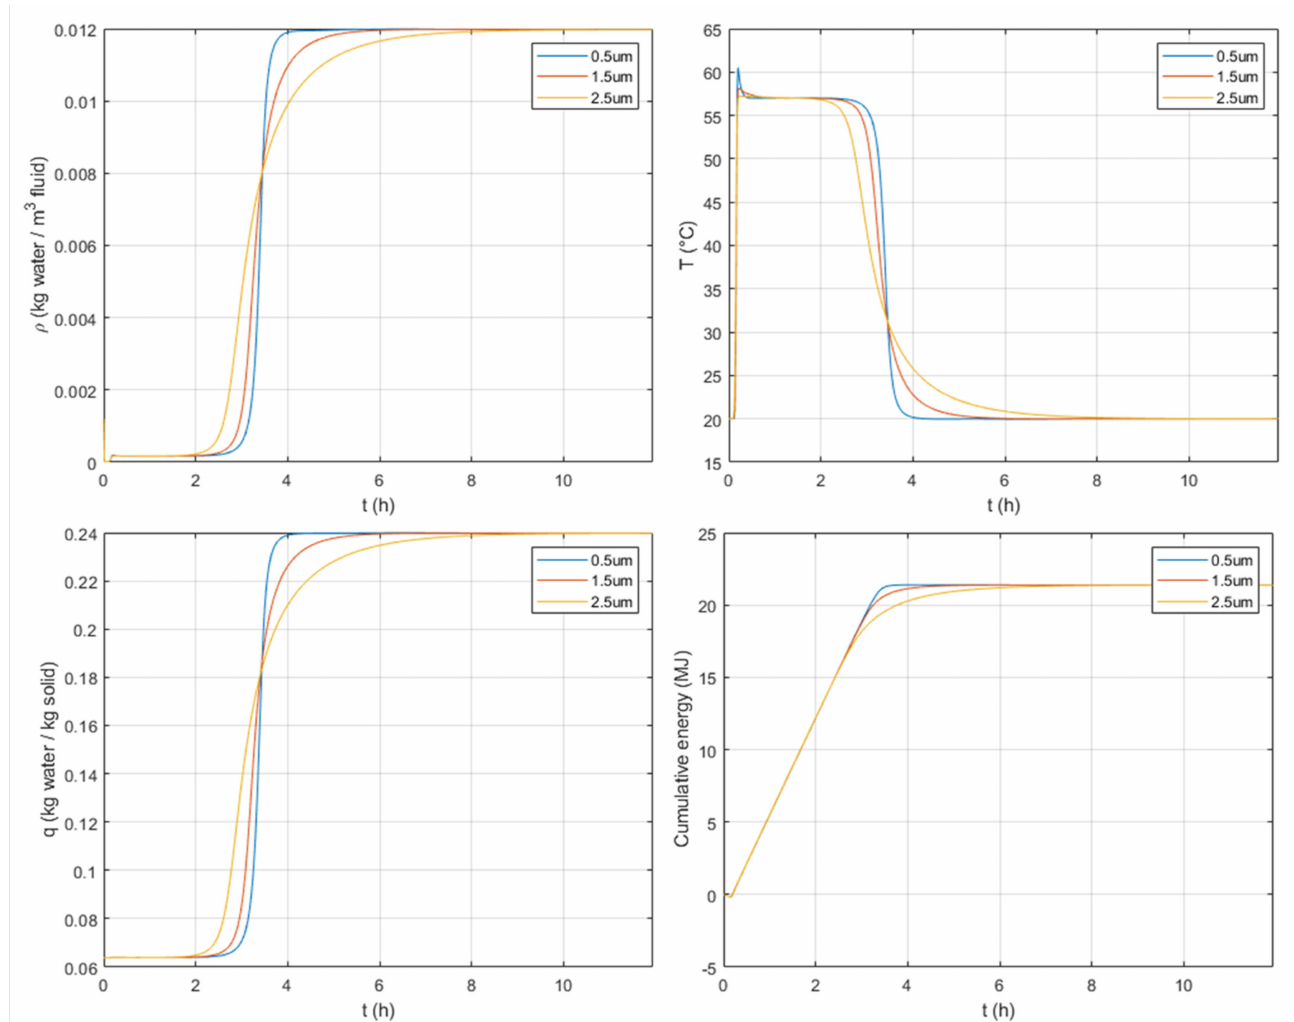
Figure 11. Parametric analysis of the crystal size and study of the evolution with time of water fluid concentration, fluid temperature, water adsorbed concentration, and cumulated heat at the column